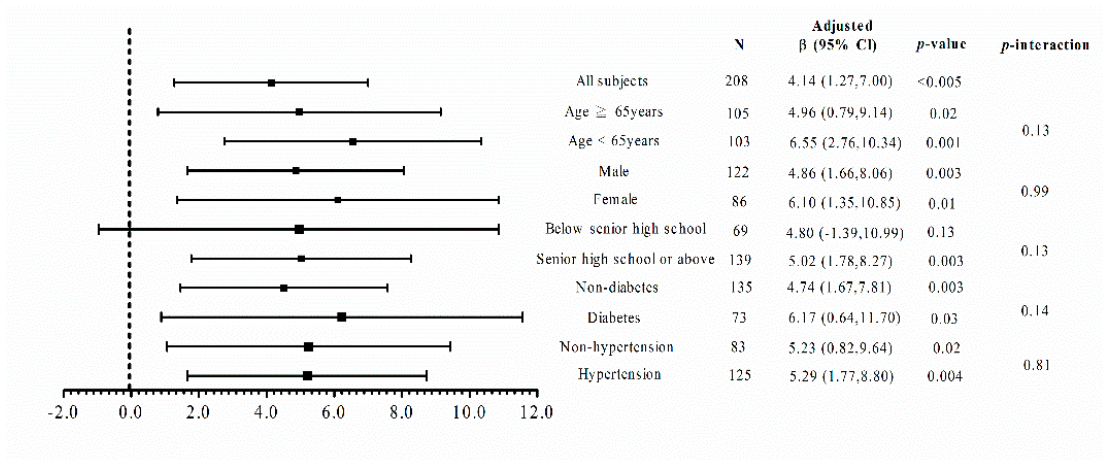
Figure 1. The correlation between self-care behavior and health literacy in different subgroups of study subjects. Adjusted β values were adjusted for age, sex, smoking status, duration of chronic kidney disease care, number of health education sessions, body mass index, uric acid, log-formed triglyceride, and the log-formed urine protein-creatinine ratio.